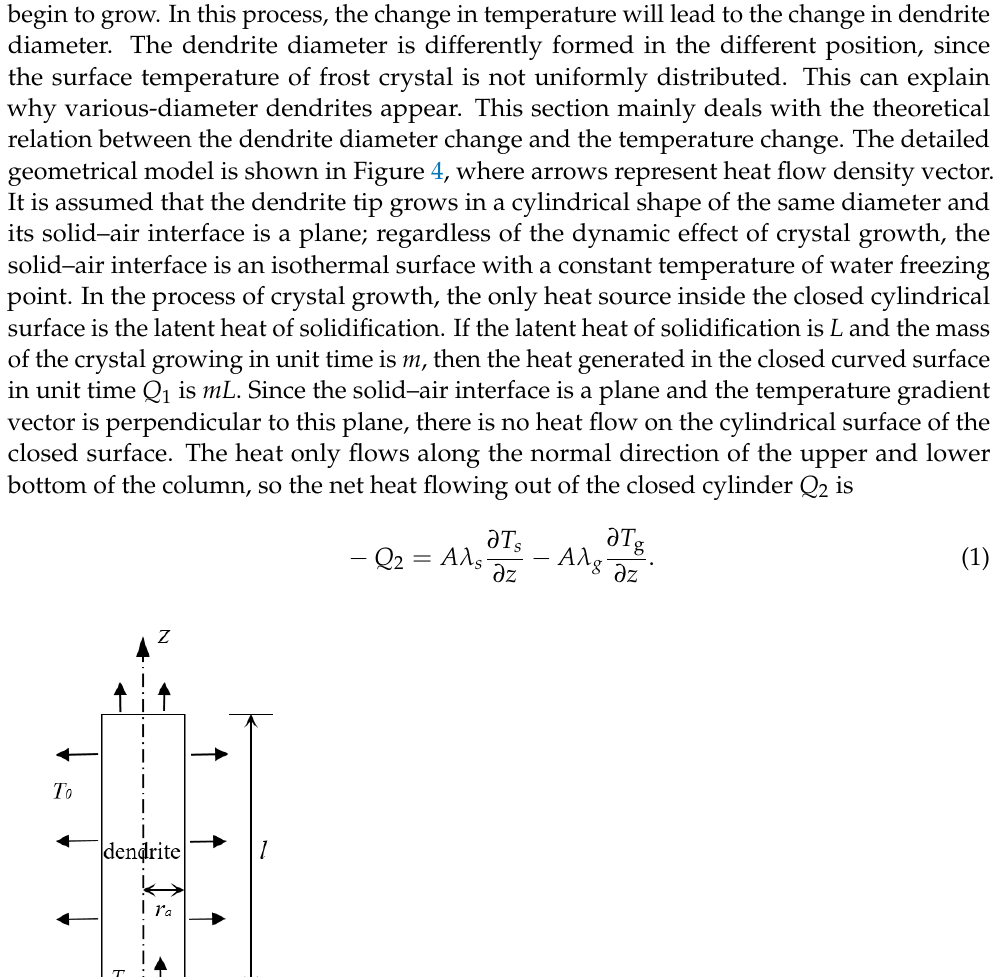
Figure 3. Illustration of heavy phase layer.